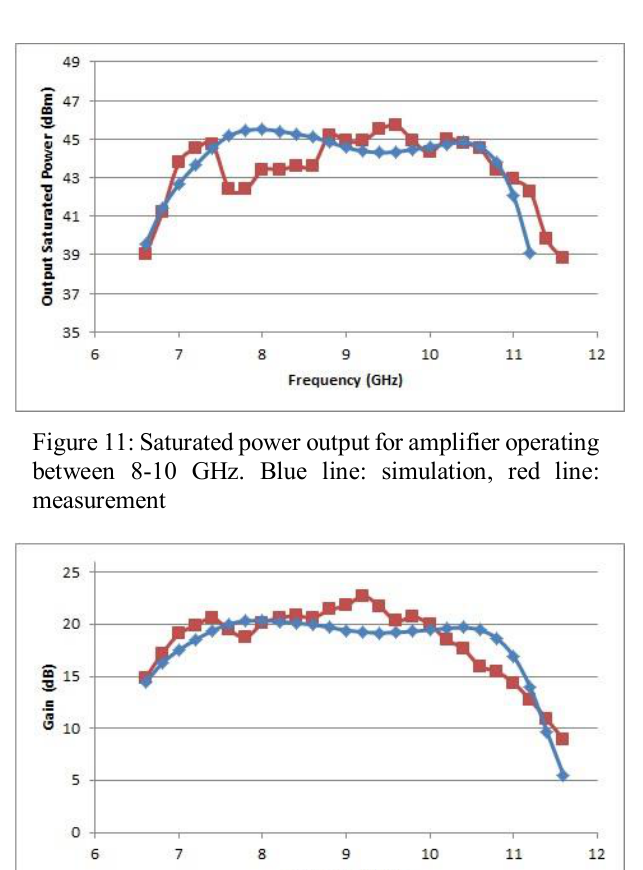
Figure 10: Manufactured PA MMIC at 10-12 GHz and placement on the PCB